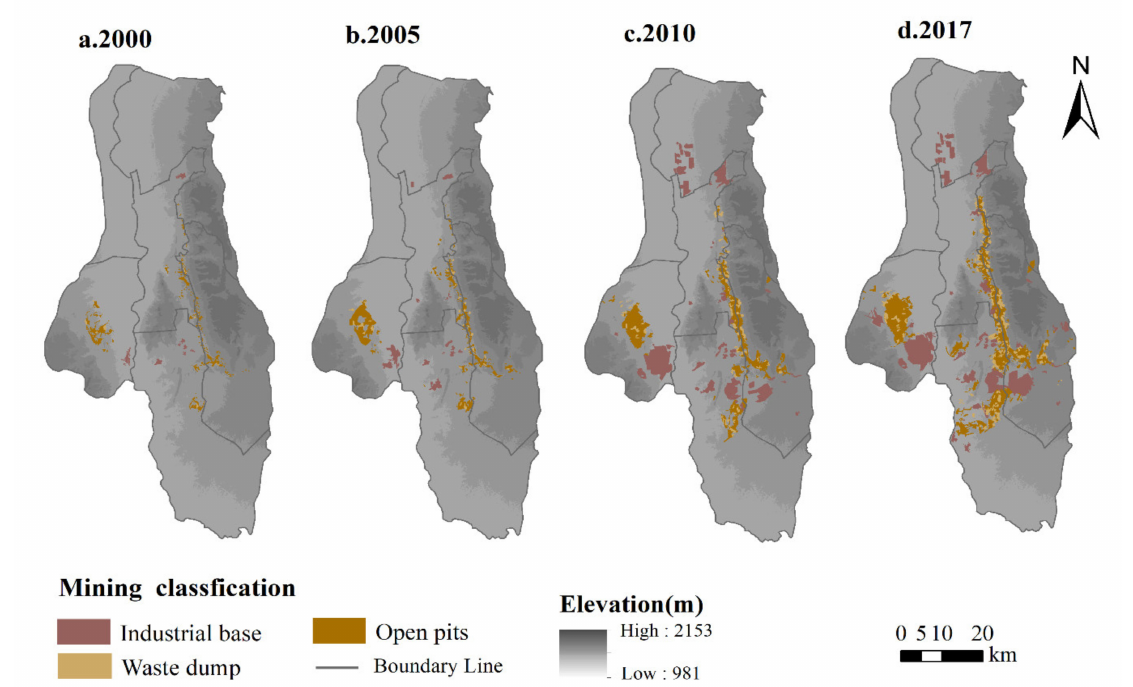
Figure 4. ( a – d ) Components and spatial distribution of mining activities in study